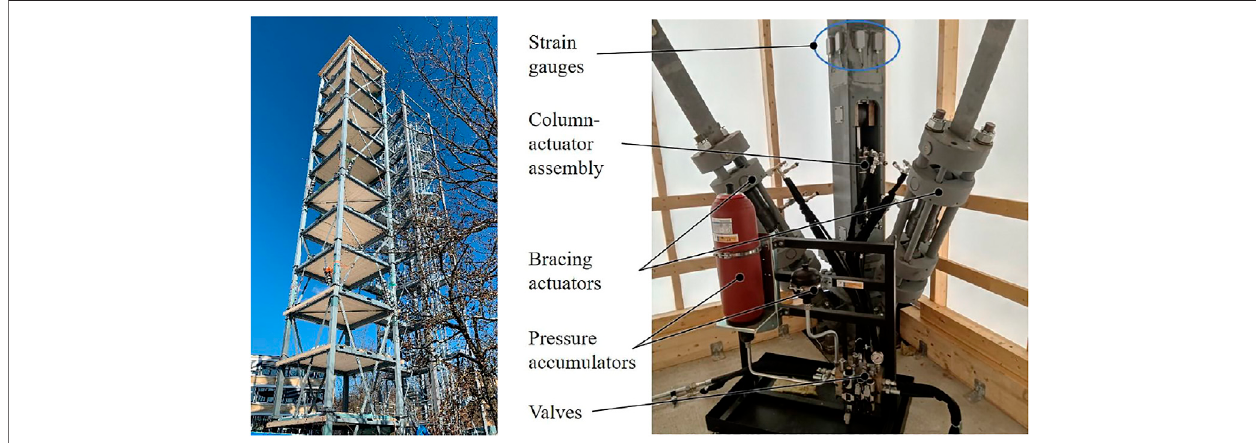
FIGURE 12 | left: D1244 during construction phase in February 2021 (Source: ILEK), right: Realization of the actuator systems inside the D1244 (Source: IKTD).